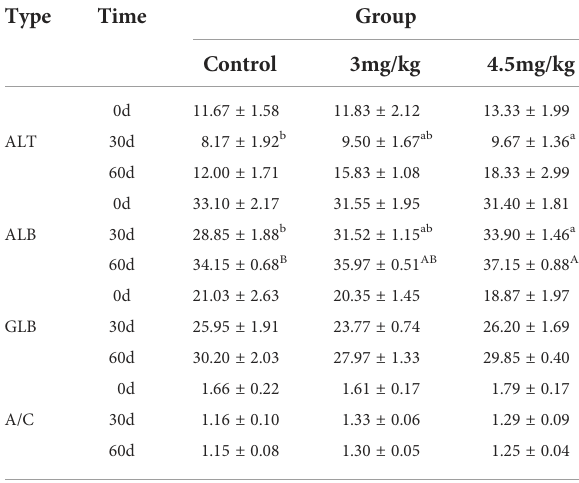
TABLE 2 Effects of melatonin implantation on liver function of sheep.